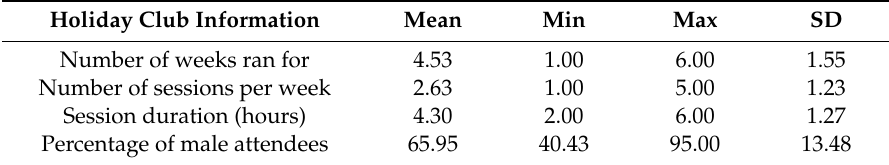
Table 1. Descriptive information on the frequency and duration of the Fit and Fed pilot clubs ( n = 15). Holiday Club Information